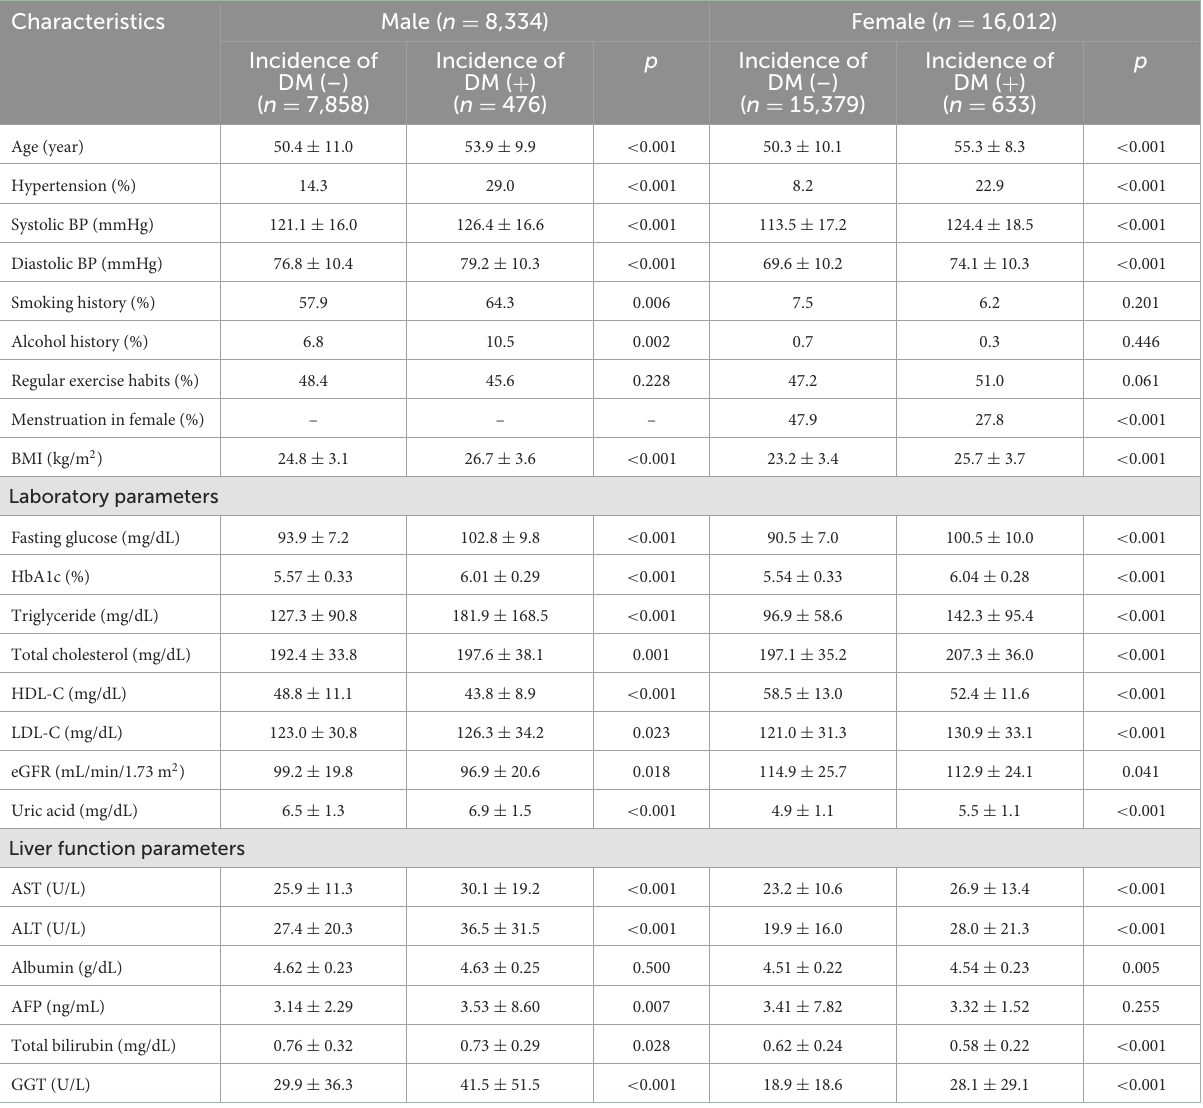
TABLE 2 Comparison of clinical characteristics of the study participants classified by the presence of different sex and incident DM.